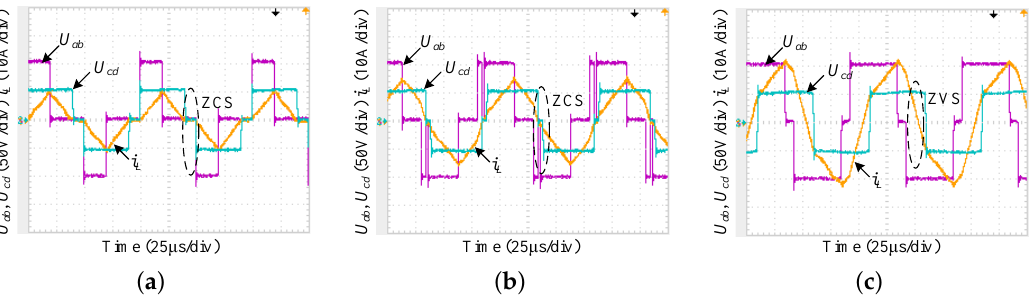
Figure 21. Experimental waveforms of DAB converter under TPSiDT scheme with M min = 0.1, k = 2, U 1 = 100 V: ( a ) P = 200 W (low power level); ( b ) P = 400 W (middle power level); and ( c ) P = 600 W (high power